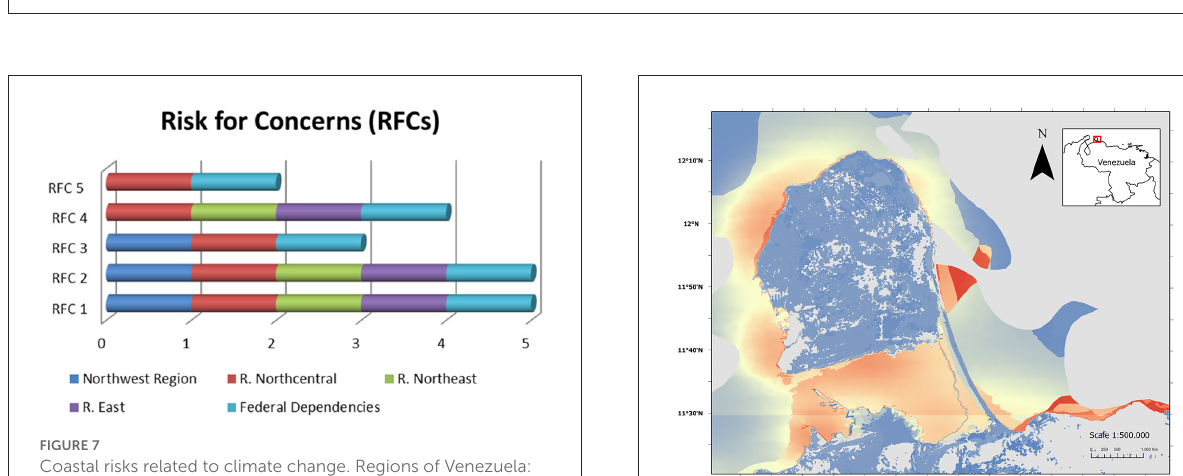
FIGURE6 Vulnerability of the coastal socio-ecological systems of Venezuela to climate change indicators. Regions of Venezuela: Northwest, Northcentral, Northeast, East, and Federal Dependencies.